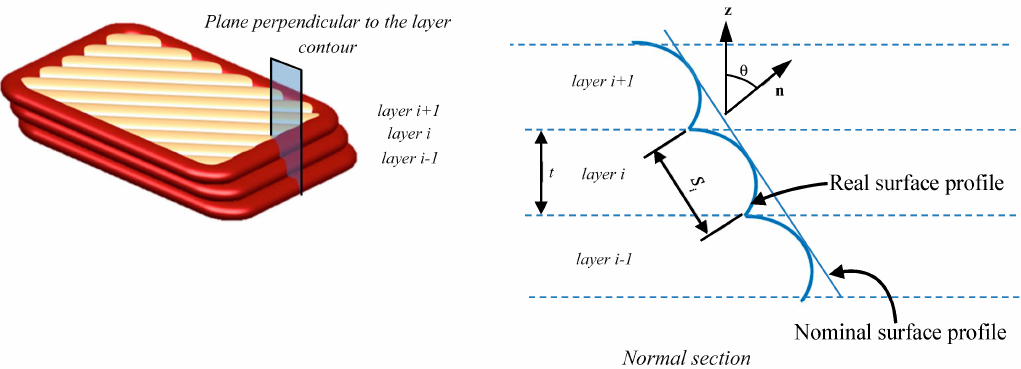
Figure 4. SLM process and staircase error (Reused from [96] with permission in accordance with Creative Common CC BY license, open access).